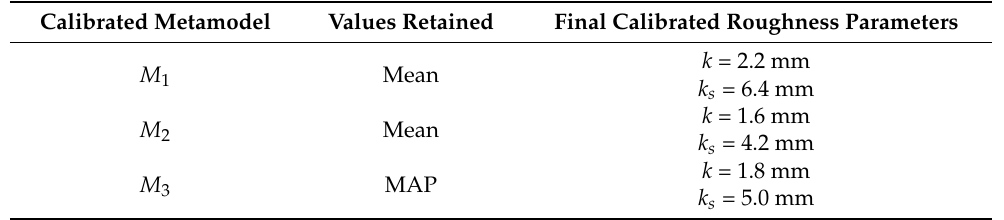
Table 7. Calibrated roughness parameters (Bayesian